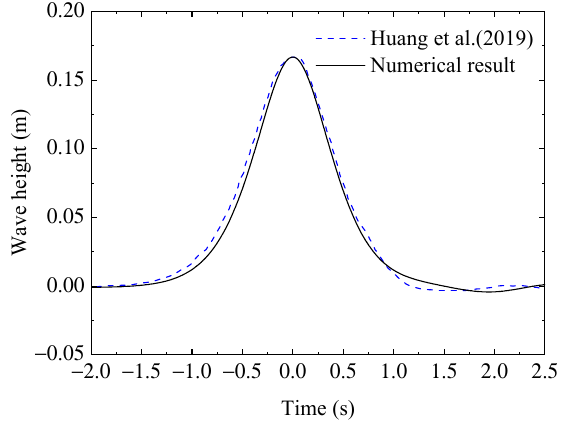
Figure 4. Comparison of the wave profile between the numerical result of current study and the experimental result of Huang et al.